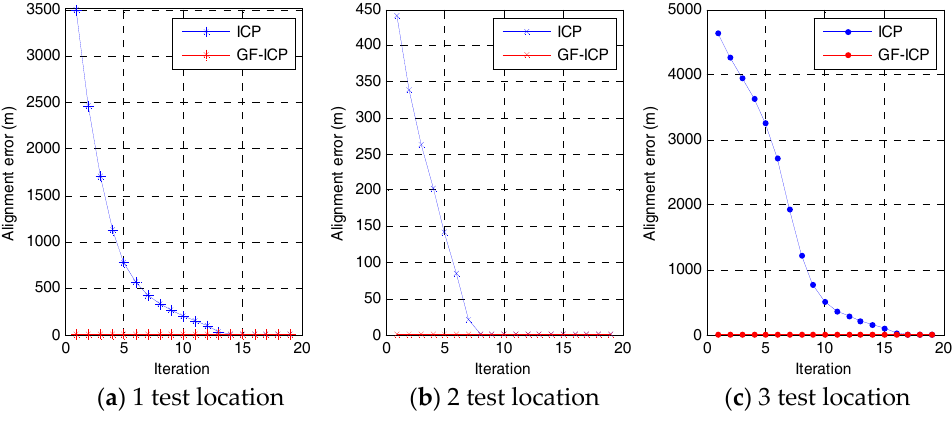
Figure 7. Comparison of convergence rate and matching error. Sensors 2017 , 17 , 1